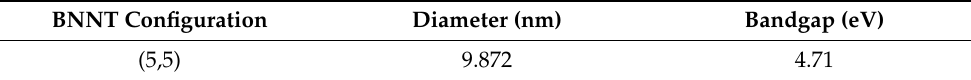
Table 1. Properties of pristine BNNT.